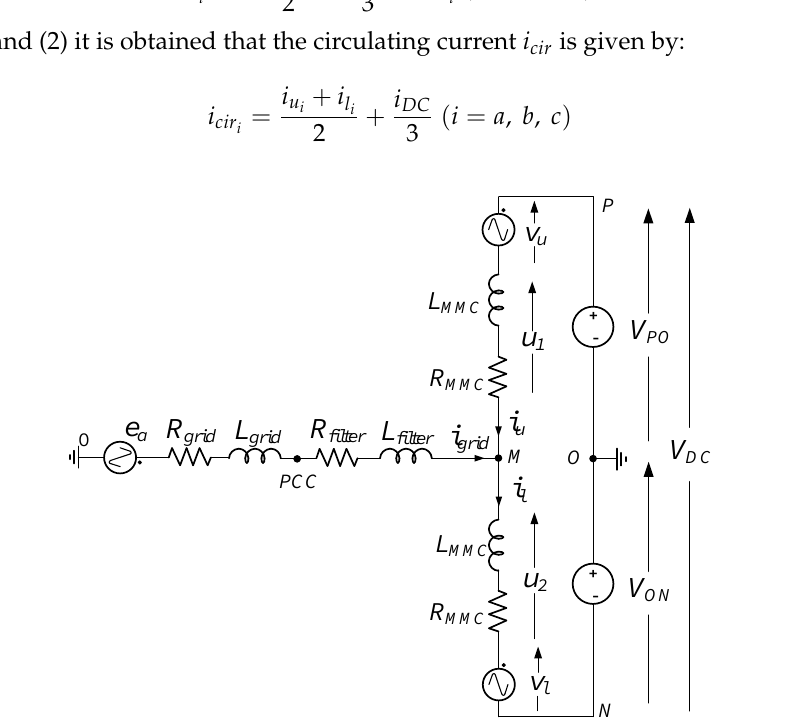
Figure 2. Modular multilevel converter equivalent model.